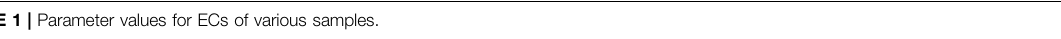
TABLE 1 | Parameter values for ECs of various samples. Sample